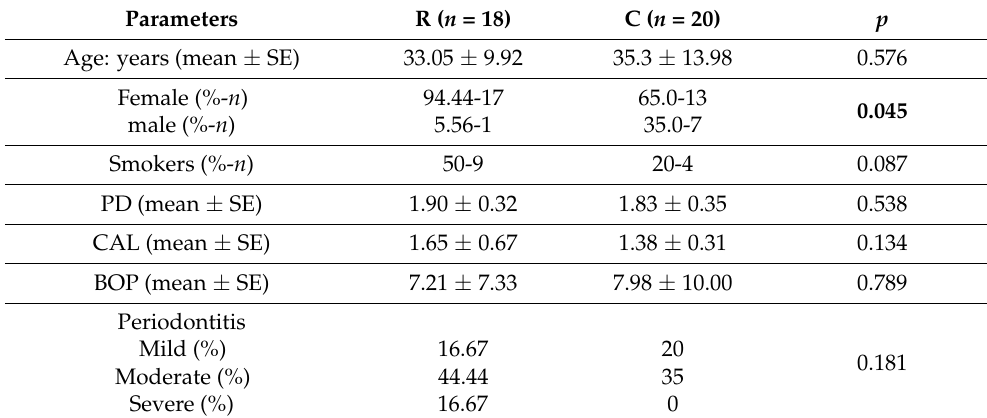
Table 1. Detailed demographic parameters and periodontal evaluation in rosacea and Control